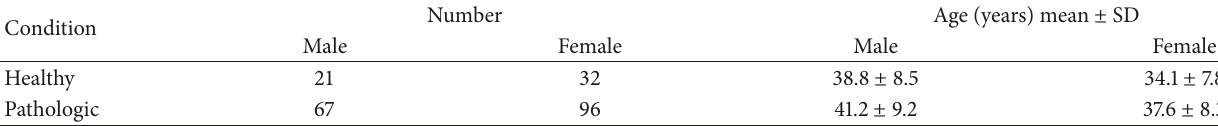
Table 1: Analyzed subjects: number and